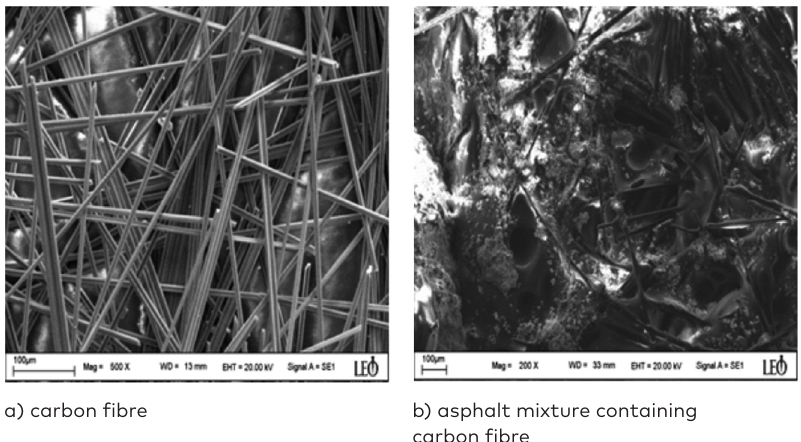
Figure 1. Images from Scanning Electron